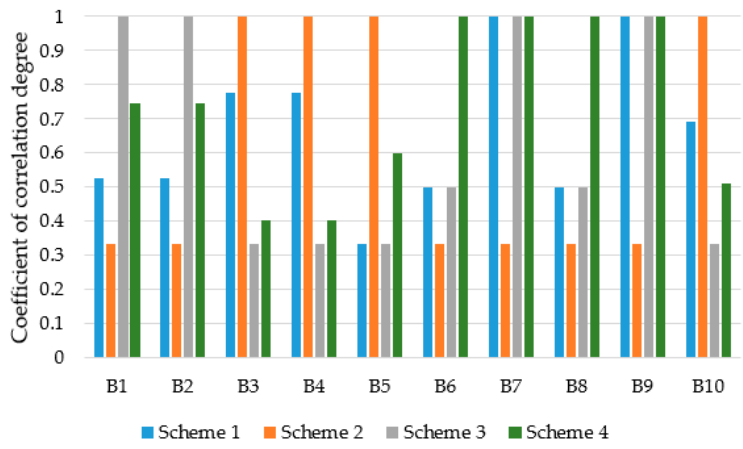
Figure 8. Relevance coefficients of various schemes under various indicators. Table 8. Ranking of schemes.